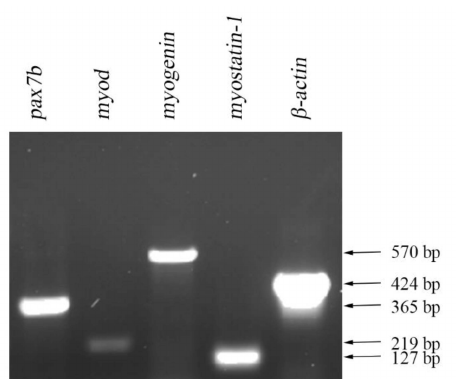
Figure 2. Expression of mRNA of myogenic regulatory proteins in primary cultured Japanese flounder muscle cells. The cDNA sequences of pax7b , myod , myogenin, and myostatin-1 were amplified by reverse-transcriptase PCR from total RNA. β -actin was included as a positive control.